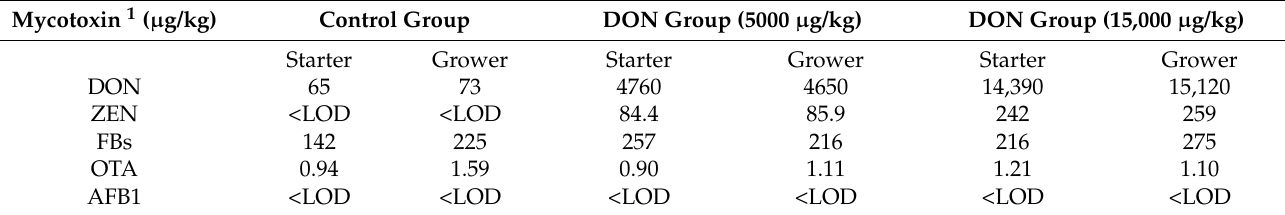
Table 3. Mycotoxin analysis of experimental feeds.